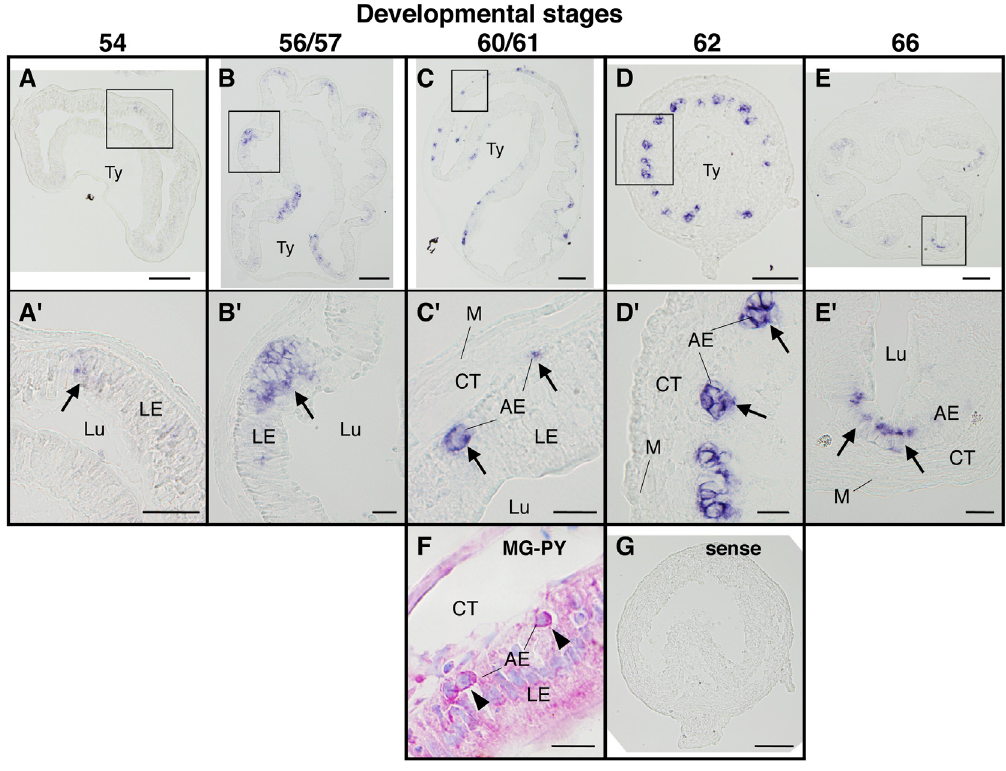
Figure 5. Spatiotemporal expression of LGR5 mRNA in the small intestine during natural metamorphosis. Cross sections of the intestine at premetamorphic stage 54 (A, A 9 ), prometamorphic stage 56/57 (B, B 9 ), metamorphic climax stages 61 (C, C 9 , F) and 62 (D, D 9 , G), and the end of metamorphosis (stage 66) (E, E 9 ) were hybridized with LGR5 antisense (A–E 9 ) or sense probe (G). To compare the localization of LGR5 mRNA (C, C 9 ) with that of adult epithelial progenitor cells, the serial sections at stage 60/61 were stained with methyl green-pyronin Y (MG-PY) (F). Arrows indicate the cells expressing LGR5 (A 9 –E 9 ), while arrowheads indicate adult epithelial progenitor cells (F). Higher magnification of boxed areas in (A)– (E) are shown in (A 9 )–(E 9 ). Sense probe did not produce any signal (G). Note that at metamorphic climax stage 61, LGR5 mRNA was localized in the islets between the larval epithelial cells and the connective tissue (C, C 9 ). These islet cells were identified as the adult epithelial progenitor cells strongly stained red with pyronin Y (F) [29]. AE: adult epithelial cell including progenitor/stem cell, CT: connective tissue, LE: larval epithelial cell, Lu: lumen, M: muscle layer, Ty: typhlosole. Scale bars are 100 m m (A–E, G) and 20 m m (A 9 –E 9 , F), respectively.